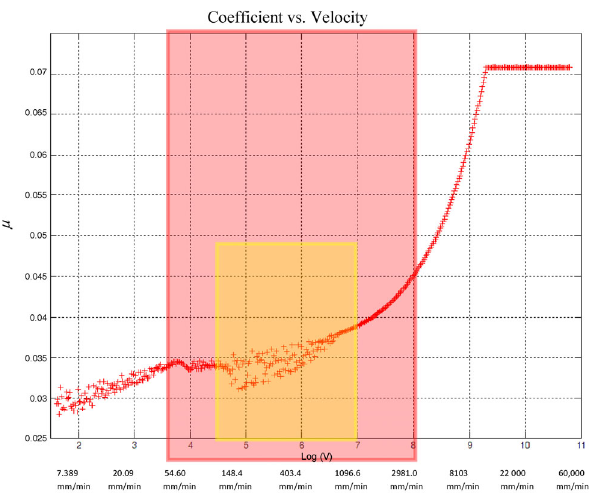
Fig. 17 Predicted COF under 20 lbf load with pin chamfer angle of 20 